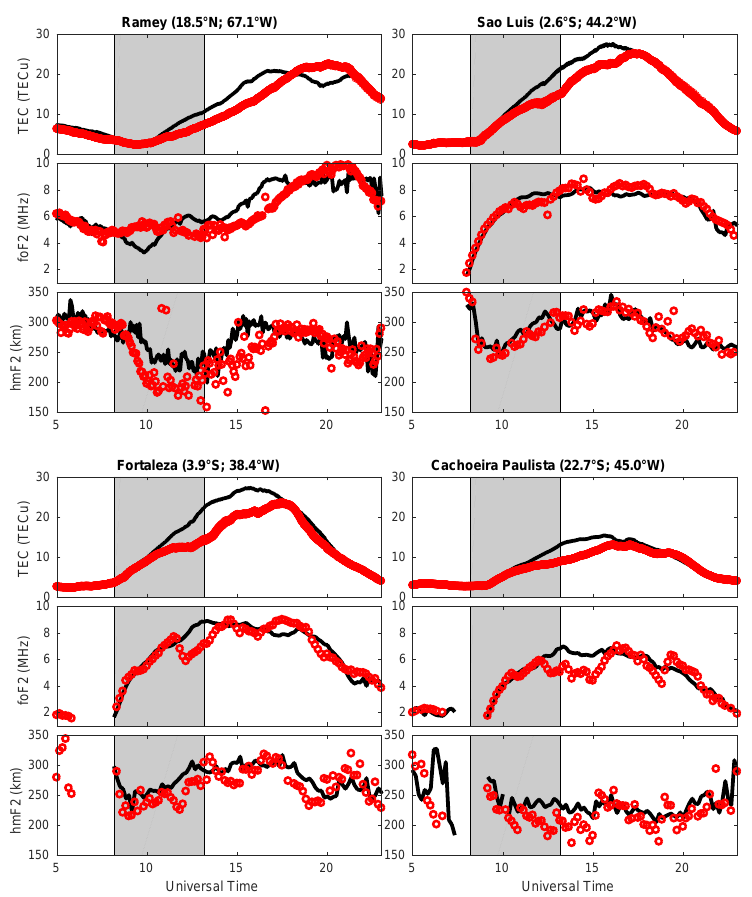
Figure 10. Comparison between TEC differences and differences in the critical frequency of the plasma (foF2) and its height (hmF2). Observations (red circles), reference variation (black line), and P1–P4 time (shaded interval) are